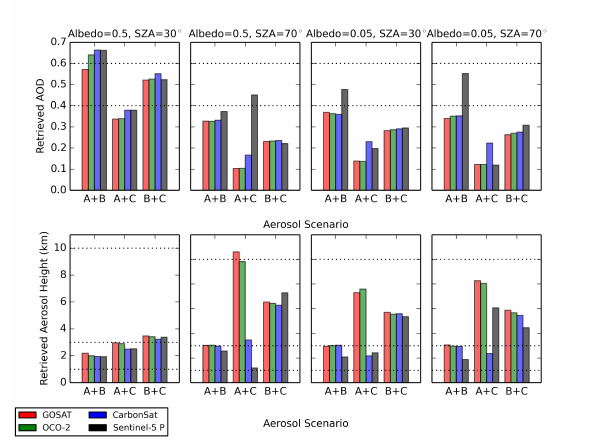
Figure 11. Total AOD error for the aerosol profile retrieval for sce- nario A for different albedo constraints given by the a priori uncer-